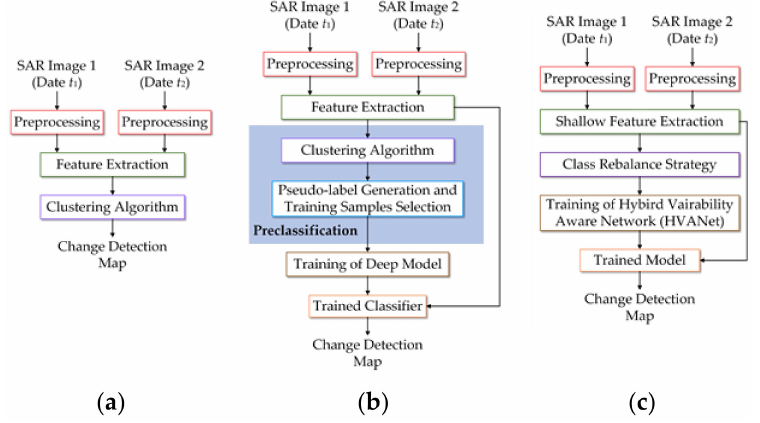
Figure 1. Three types of CD framework for SAR images. ( a ) Conventional clustering-based CD framework. ( b ) Preclassification scheme. ( c ) The proposed label-free CD